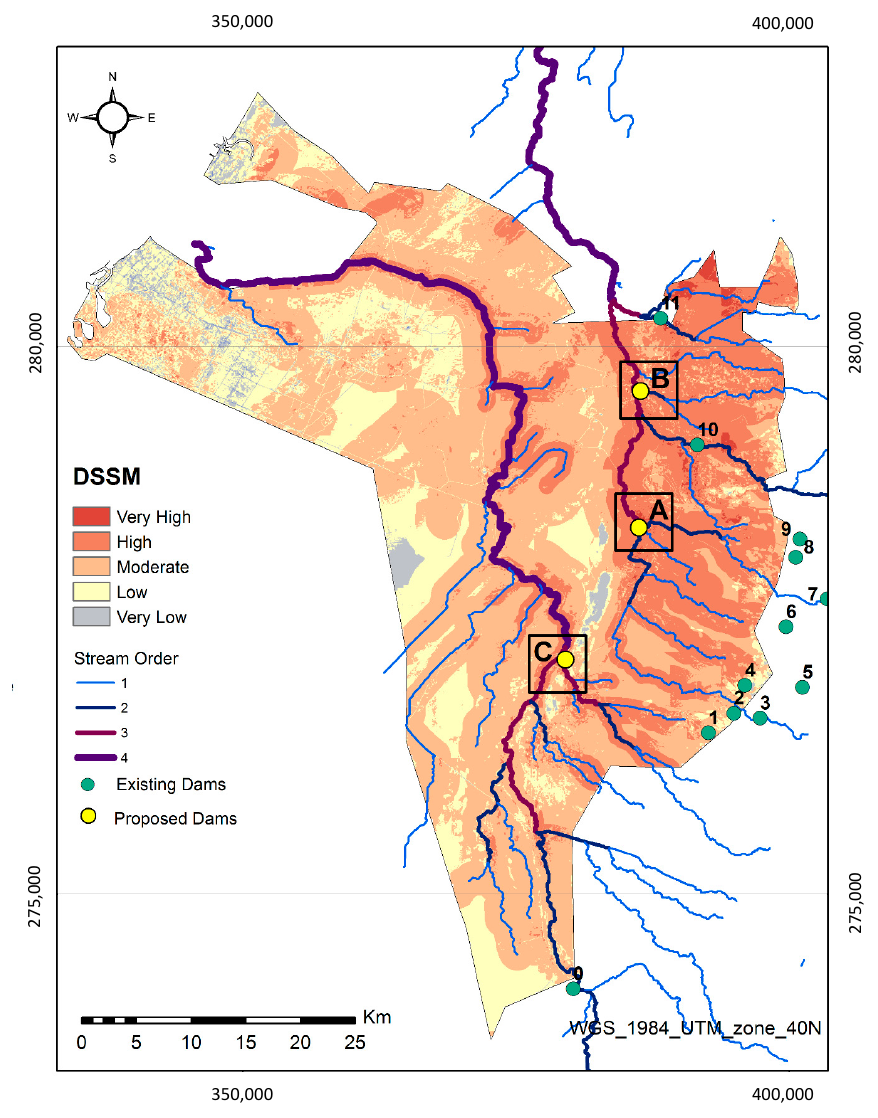
Figure 5. Dam site suitability map with dams and streams. Table 7. Dam storage capacity for accuracy